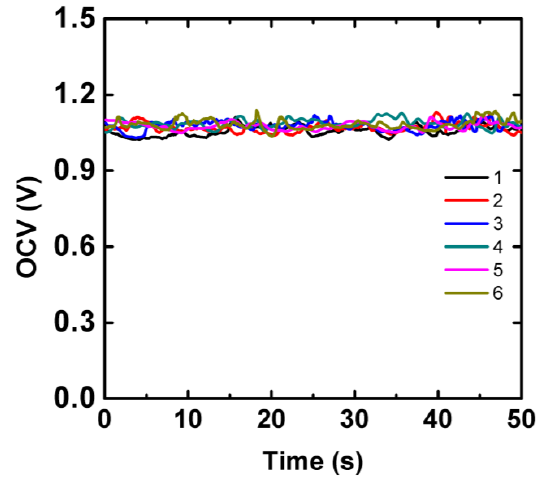
Figure 3. The average OCV of the aluminum-air battery as a function of time measured from six individual cells.